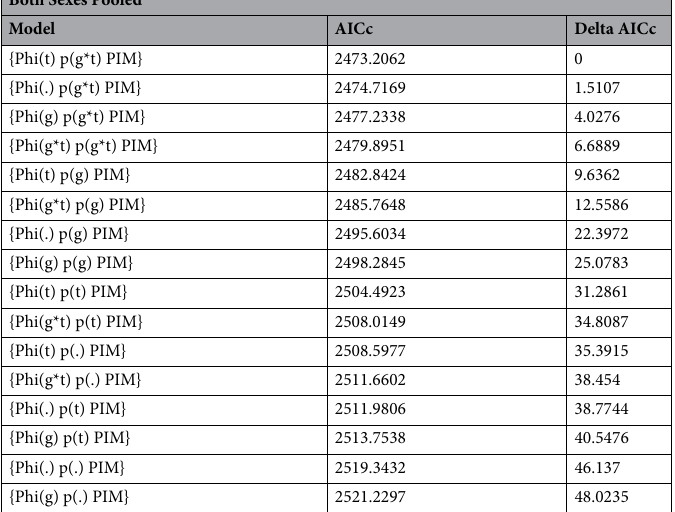
Table 1. Ranking of Cormack-Jolly-Seber models estimating annual rates of survival (Phi) and recapture (p) of turtle-headed sea snakes ( Emydocephalus annulatus ) in three populations. Models differ in whether or not survival and recapture rates are constant (.), vary over time (t), vary among populations (g) or vary interactively with time and population (g*t). The two top-ranked models (in which survival rates were constant or varied over time) fit the data four times better than the top model in which survival varied among populations (Phi(g*t) p(g*t). AICc = corrected Akaike Information Criteria; delta AICc = disparity between a model and the top-ranked